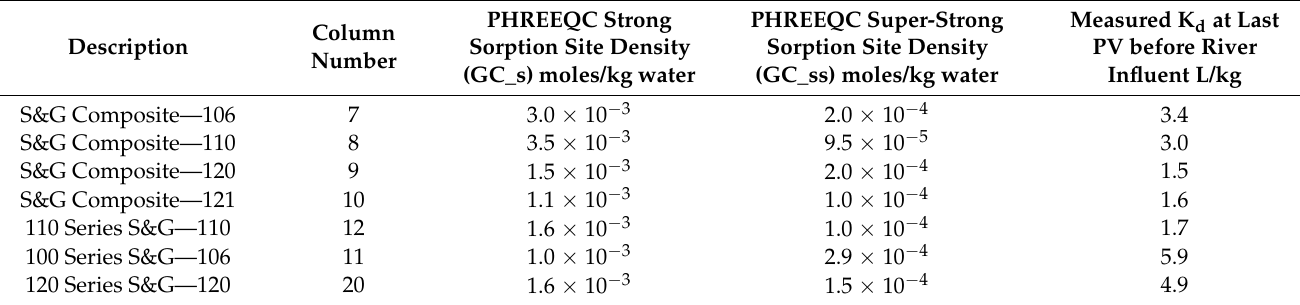
Table 4. Summary of final PHREEQC parameter values for the saturated zone